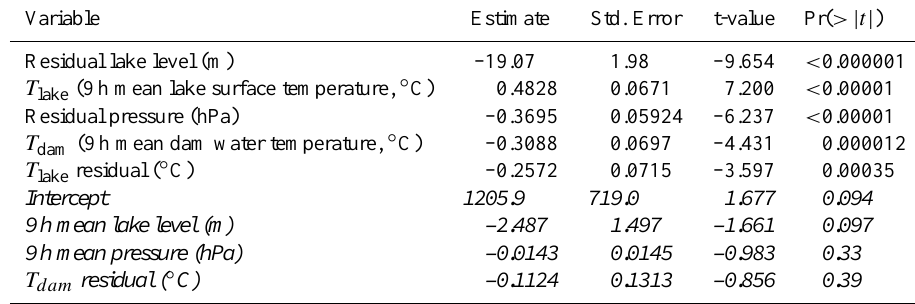
Table 2. Multiple linear regression between the log-transformed CH 4 effluxes from Lake Wohlen and potential driving variables with 9-h retrospective boxcar smoothing that led to highest overall explanation of variance (adj. R 2 = 0 . 35). Lines in italics are not significant ( p > 0 . 05). T lake and T dam denote lake surface ( − 0.1m) and dam water ( − 10m) temperatures,